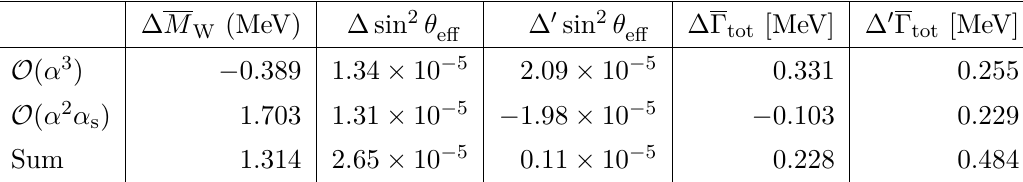
Table 3 . This table shows the numerical results of the leading fermionic three-loop corrections to EWPOs at O ( α 3 ) from ref. [36] and at O ( α 2 α s ) presented here. One can see that the two contri- butions have comparable size, except for ∆ M W , where the mixed EW-QCD three-loop correction is about four times larger in magnitude than the pure EW three-loop.